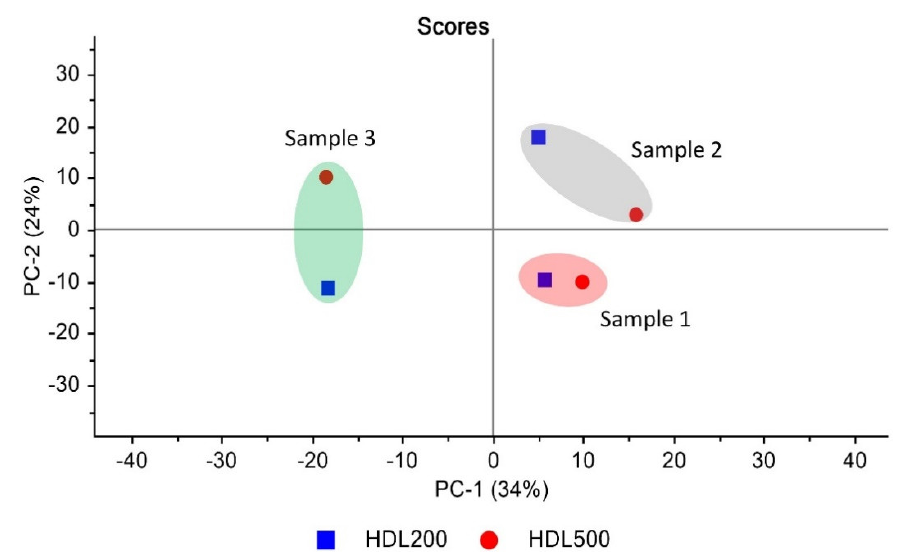
Figure 3. PCA of the HDLs isolated from different volumes of sera. PCA score plots were generated using the 4000–650 cm − 1 region. There are three clusters of serum samples, and each cluster consists of spectra from HDL200 (blue) and HDL500 (red).